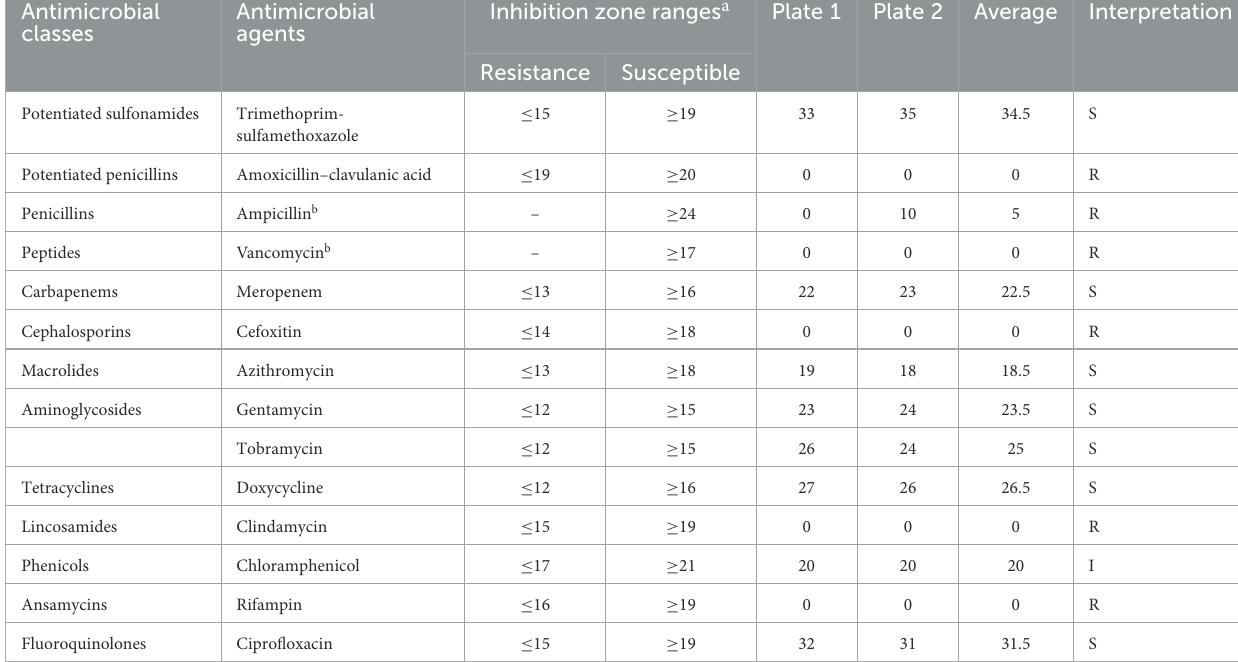
TABLE 1 Agar diffusion test results. Antimicrobial